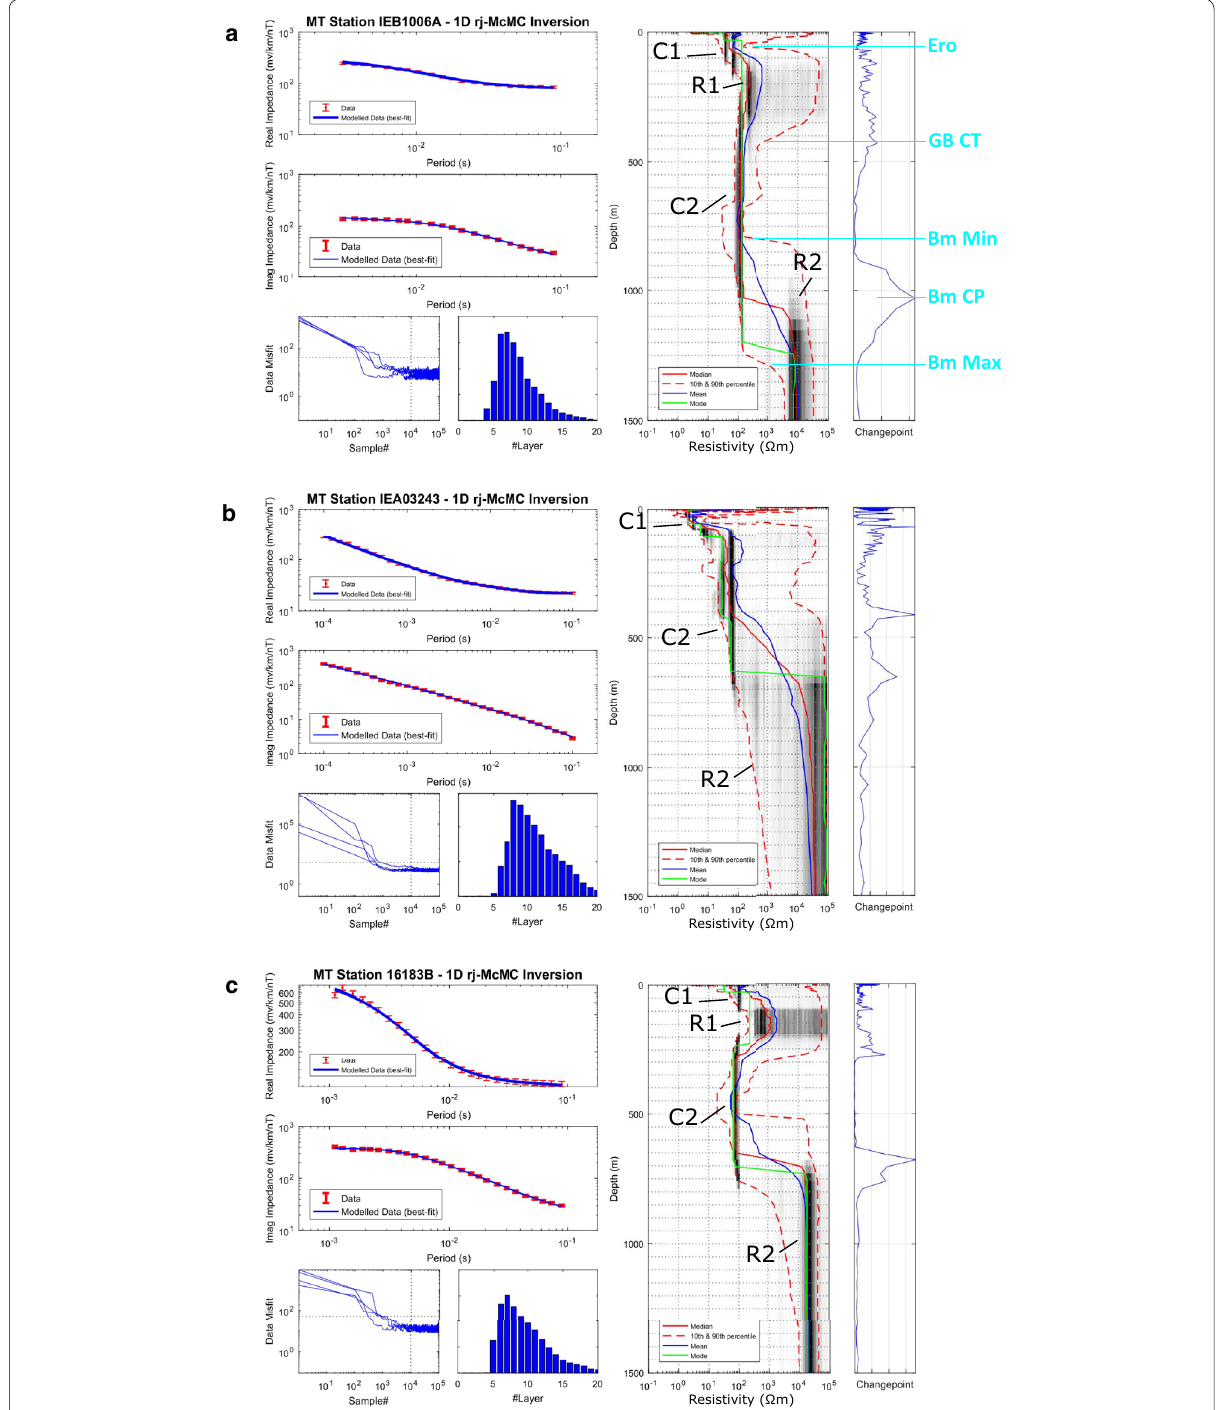
Fig. 6 Typical rj-McMC 1D MT inversion results. a A BBMT site with interpretation picks indicated in cyan, b a full frequency AMT site and c reduced frequency AMT site. The data fit, misfit convergence, predicted number of layers and change point prediction curve for each site are displayed alongside the inversion model. The black-white colouration on the 1D model indicates model probability, with black areas indicating high probability structure. Inversion result plots for all MT sites can be found in Additional file